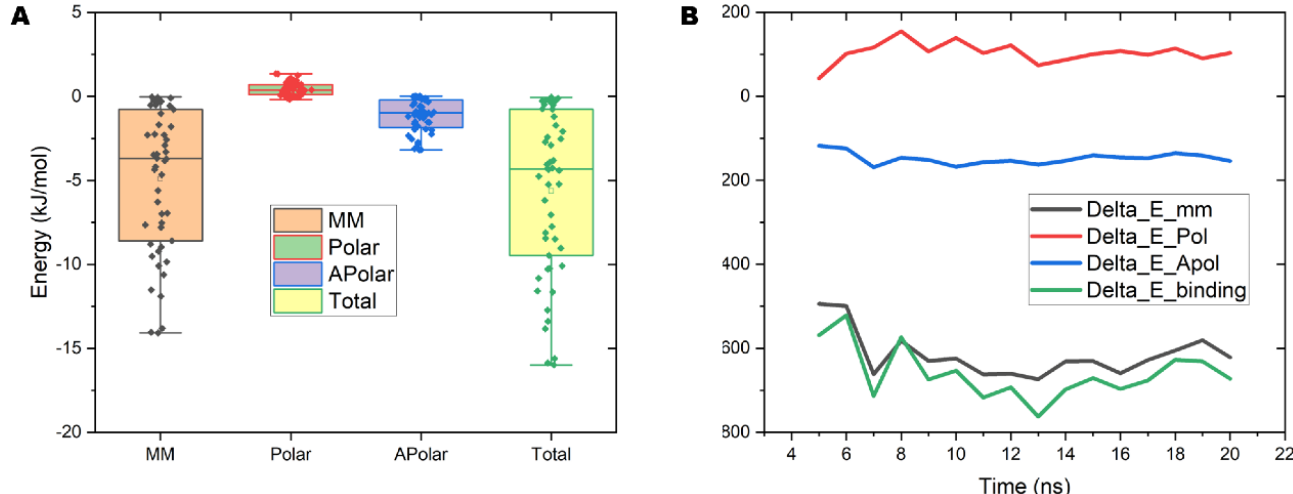
Figure 6. Decomposition and distribution of the binding free energy of PVC10 permeation in the lipid bilayer. ( A ) Decomposition of the binding free energy of PVC10-membrane complexes using g_mmpbsa. Sample sizes are shown as individual dots within each box (MM, molecular mechanics energy, Polar, polar solvation energy; apolar, nonpolar solvation energy; Total, total binding energy). ( B ) Distribution of the binding free energy of the PVC10-membrane system versus time.